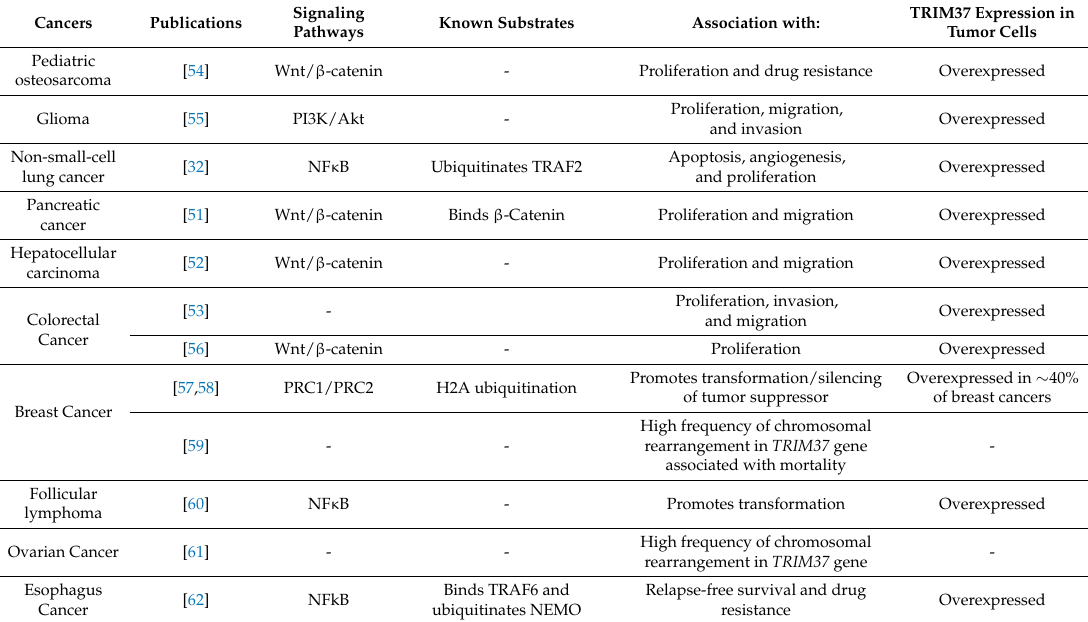
Table 2. TRIM37 dysregulations in